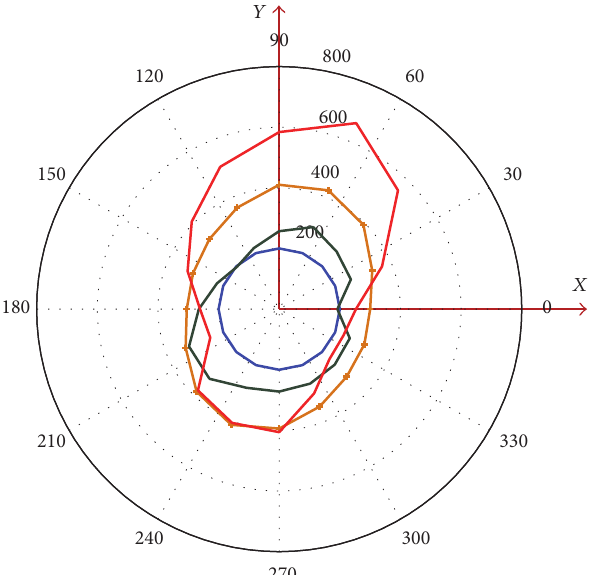
Figure 16: UJB pads clearances ( 𝜇 m): (a) nominal (condition A, blue); (b) measured at 0MW (condition B, green); (c) simulated at 700 MW (condition C, crossed orange); and (d) measured at 700 MW (condition D,